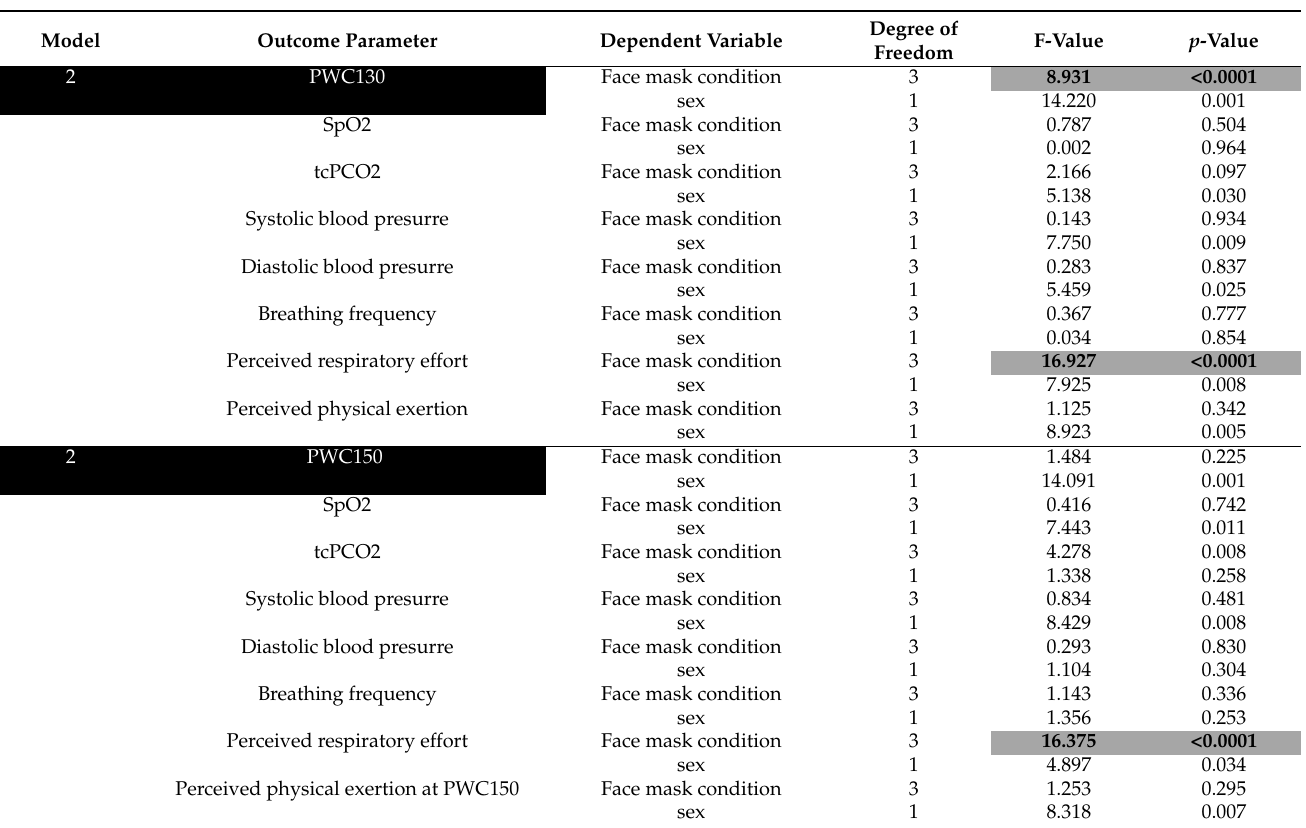
Table A5. Comparison of all face masks including face mask condition and sex—linear mixed model